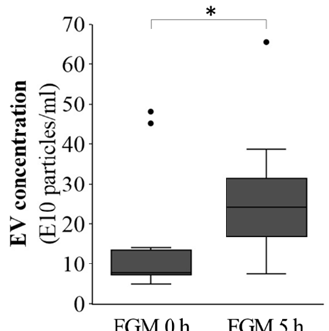
Figure 2. EV concentration before and 5 h after first dose of fingolimod. A significant 1.98 ‐ fold change (FC) increase in the concentration of isolated EVs was observed 5 h after the first dose, measured by NTA. * p < 0.05. n = 11.